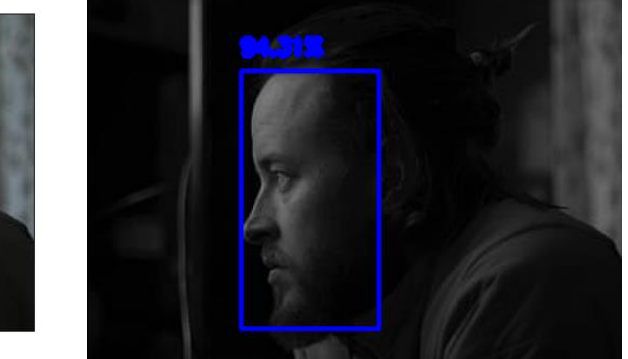
Figure 5 . Result showing face detection in image using our proposed model [86].